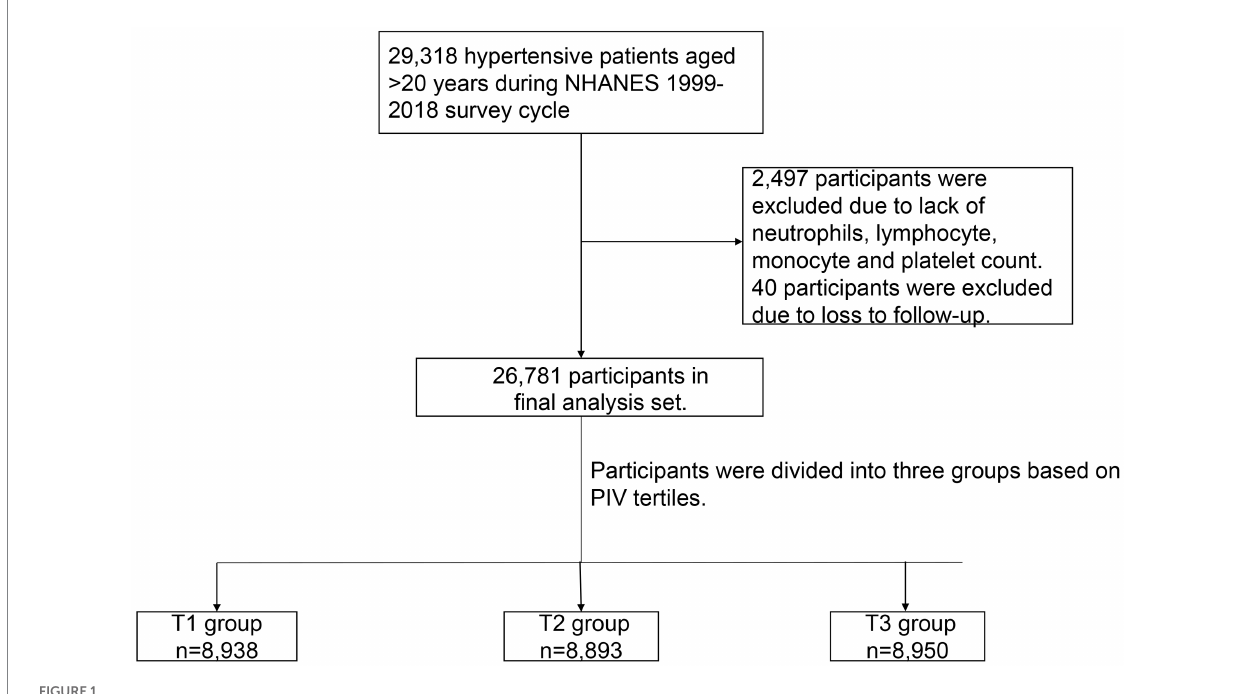
FIGURE 1 Flowchart of the study